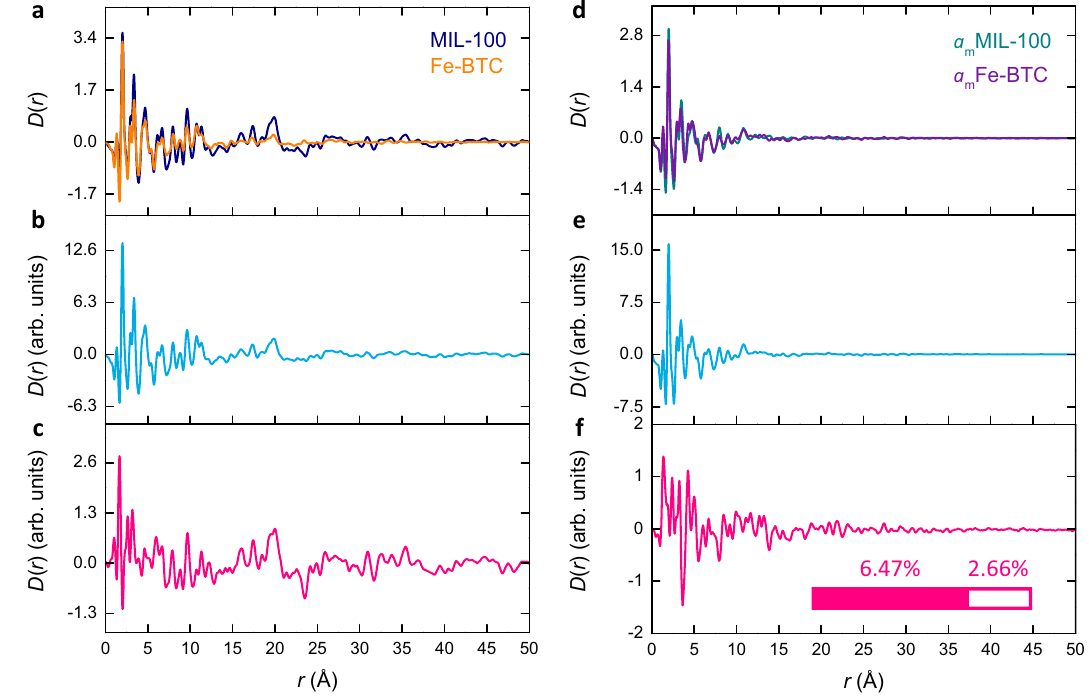
Fig. 4 Fingerprinting disorder. a Experimental PDFs for MIL-100 (navy) and Fe-BTC (orange), and the corresponding ( b ) fi rst and ( c ) second principal components extracted through PCA, which describe atom – atom correlations and a structural distortion, respectively. d Experimental PDFs for a m MIL-100 (turquoise) and a m Fe-BTC (purple), and the corresponding ( e ) fi rst and ( f ) second principal components extracted through PCA, which describe atom – atom correlations and a structural distortion, respectively. The inset in ( f ) represents the relative magnitudes of the distortion between MIL-100 and Fe-BTC ( fi lled) and a m MIL-100 and a m Fe-BTC